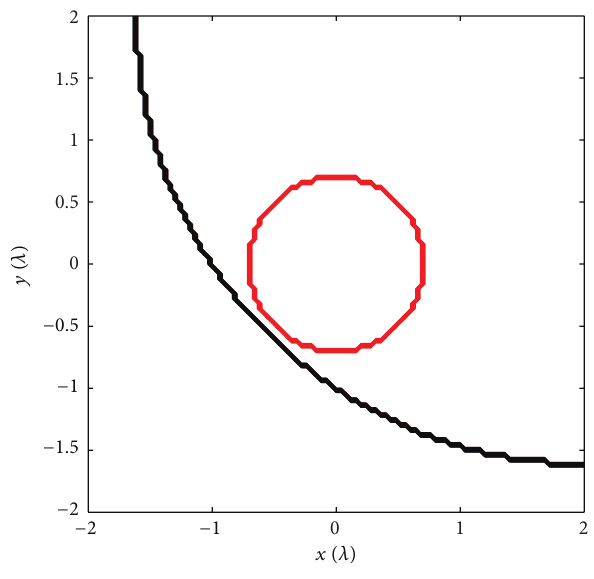
Figure 10: Boundary of the minimum source region defined by 𝑅 min for test origin (𝑥 = 2, 𝑦 = 2) .